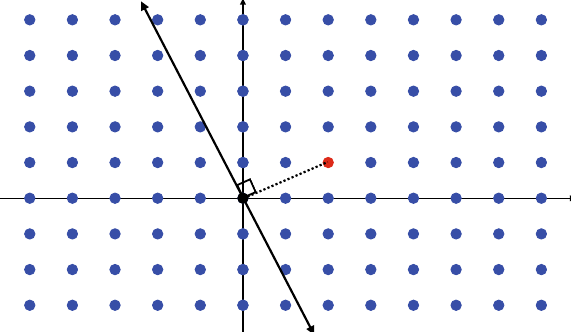
Fig. 2 Higgsing in a lattice with e 2 orthogonal to the Higgsed particle (shown in red) does not intersect any lattice points, then the WGC (and sLWGC) need not be satisfied in the resulting